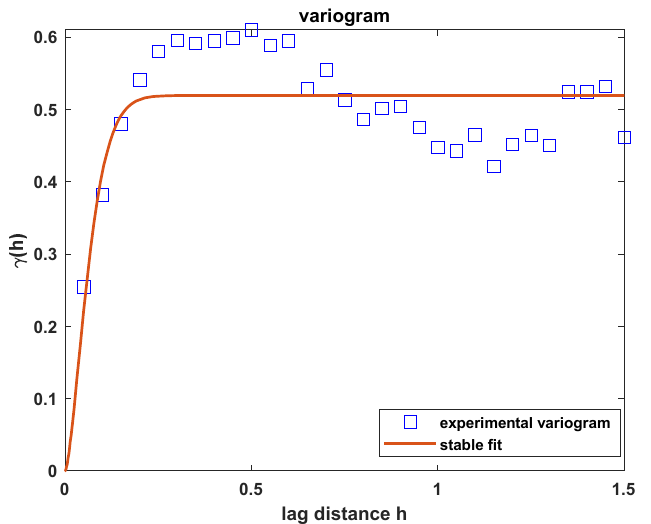
Figure 6. Experimental variogram (blue squares) based on the Gini index for 96 measurement points that were modelled by a stable function (red line).